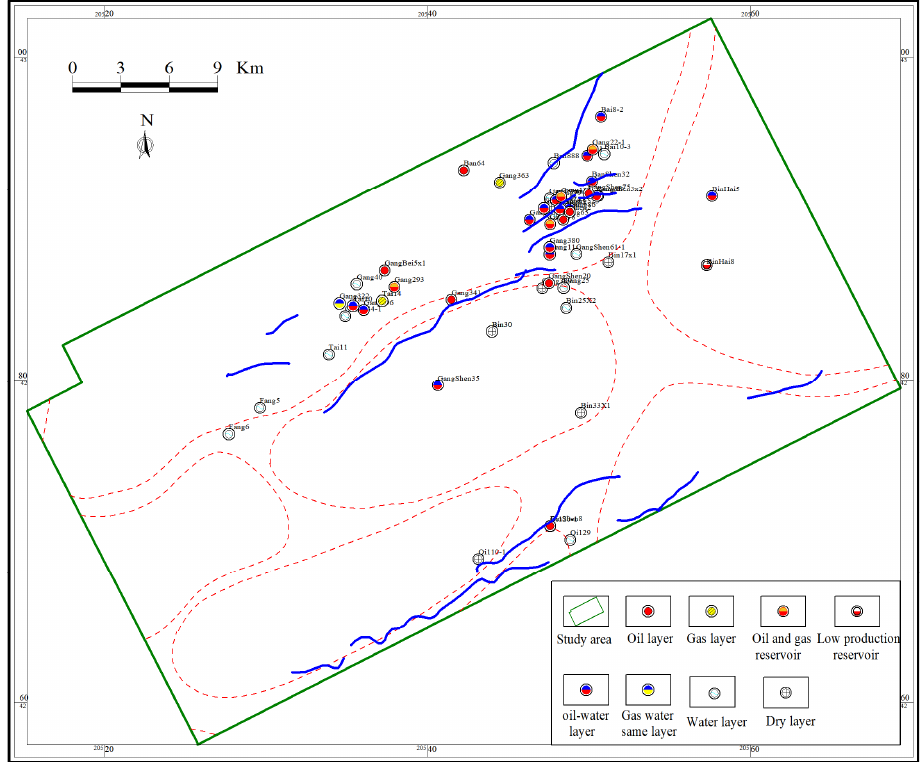
Figure 4. Coupling of fault-shale caprock configuration leakages at the Sha-1 Member and discov- ered oil and gas at the Ed-3 Member in the south of the northern Dagang area. oil and gas at the Ed-3 Member in the south of the northern Dagang